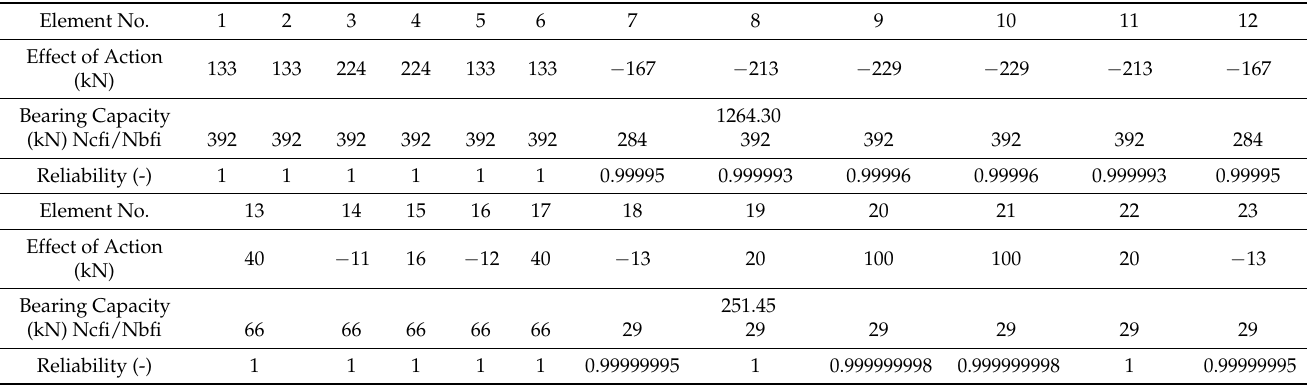
Table A1. Effect of action, bearing capacity, and reliability of analyzed truss elements in 30th minute of fire